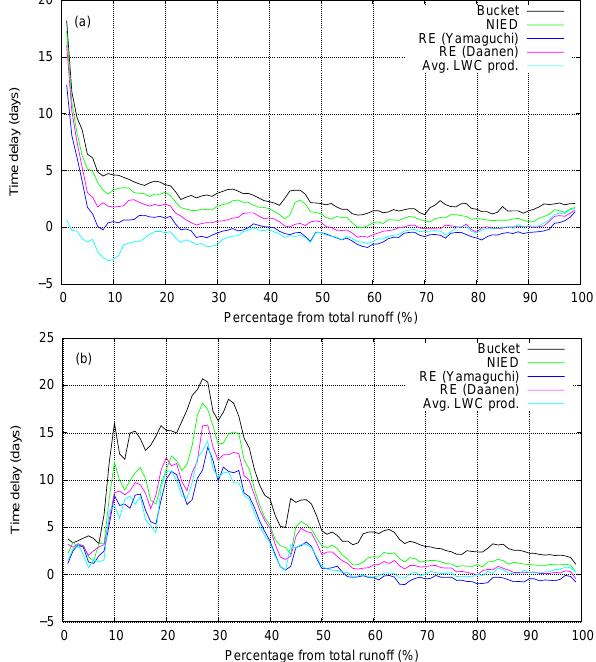
Fig. 4. Average delay over all simulated years between modelled and observed snowpack runoff as a function of percentage of total melt season snowpack runoff (for WFJ (a) , starting 1 March) or total snow season snowpack runoff (for CDP, b